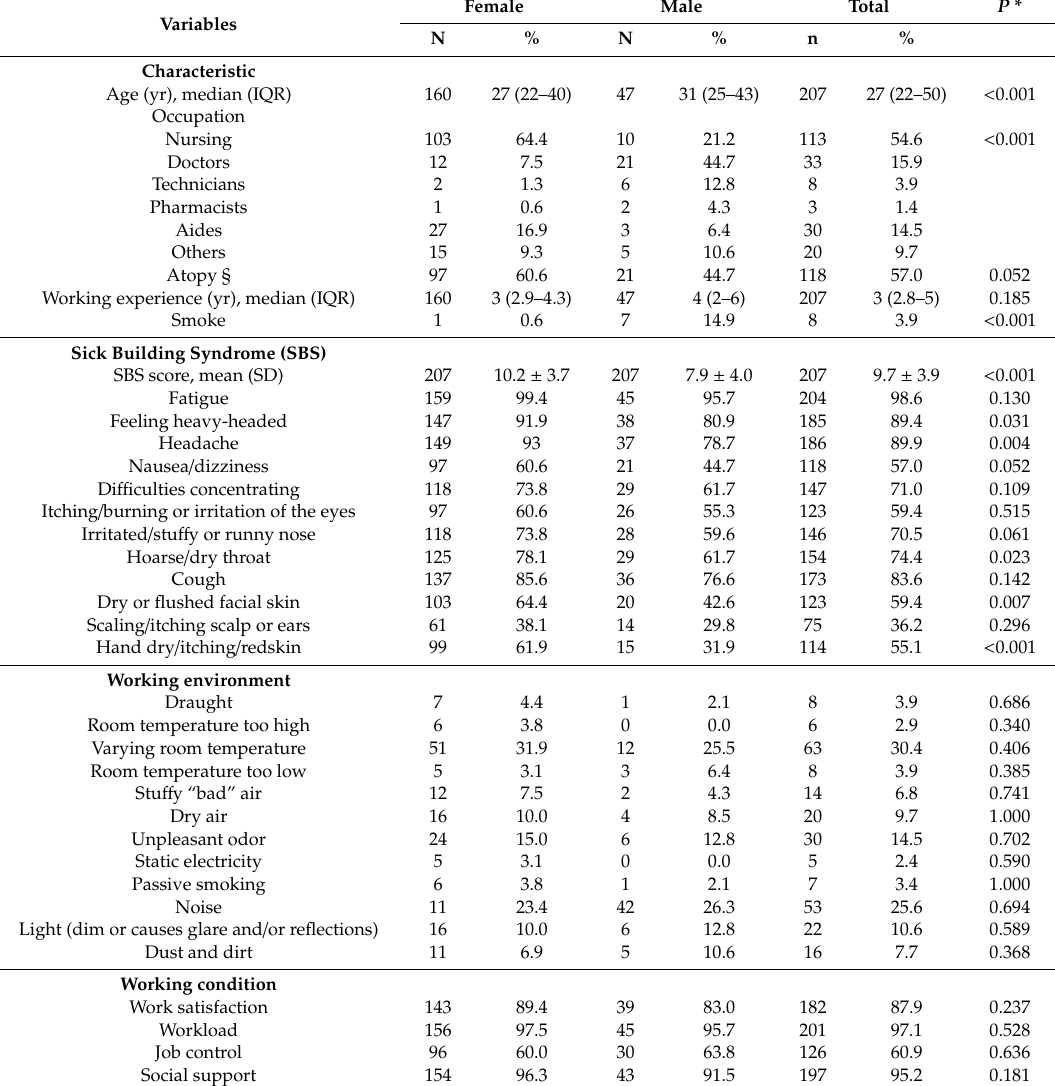
Table 1. Sick building syndrome (SBS) symptoms, working environment, and working condition characteristics among female and male healthcare workers (n =